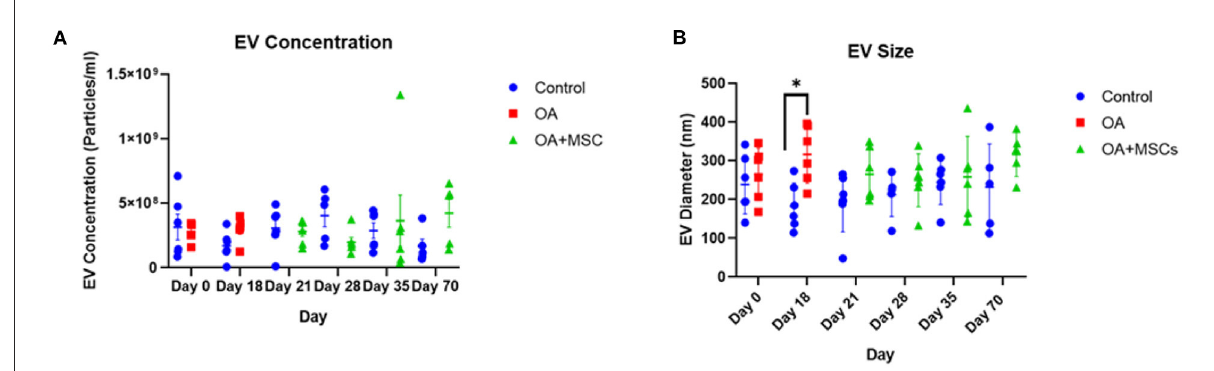
FIGURE1 Size and concentration of synovial fluid-derived nanoparticles. Nanoparticle tracking analysis was undertaken using a Nanosight NS3000. All error bars are standard error of the mean (SEM). Statistical analysis undertaken in GraphPad Prism 9.0 using Kruskal Wallis tests with FDR correction and Mann Whitney tests within time points ( p < 0.05, *; p < 0.01 **: p < 0.001, ***, p < 0.0001, ****). (A) EV concentration and (B) EV